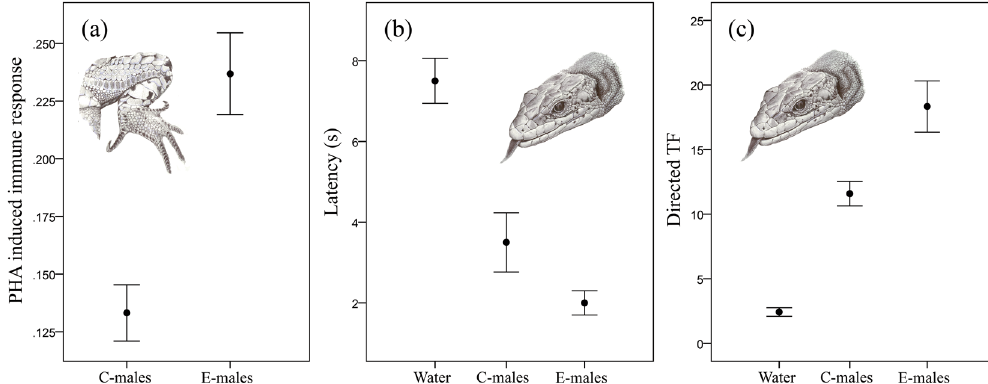
Figure 2. Effect of vitamin E dietary supplementation on the immune response of Iberolacerta cyreni male lizards and chemosensory responses of females to scent of males. ( a ) Immune response measured in control (C-males) and supplemented (E-males) male lizards. ( b ) Latencies (mean ± SE in s) and ( c ) number (mean ± SE) of directed tongue-flicks (TF) elicited by female lizards to swabs with deionised water and scents from femoral secretions of C-males and